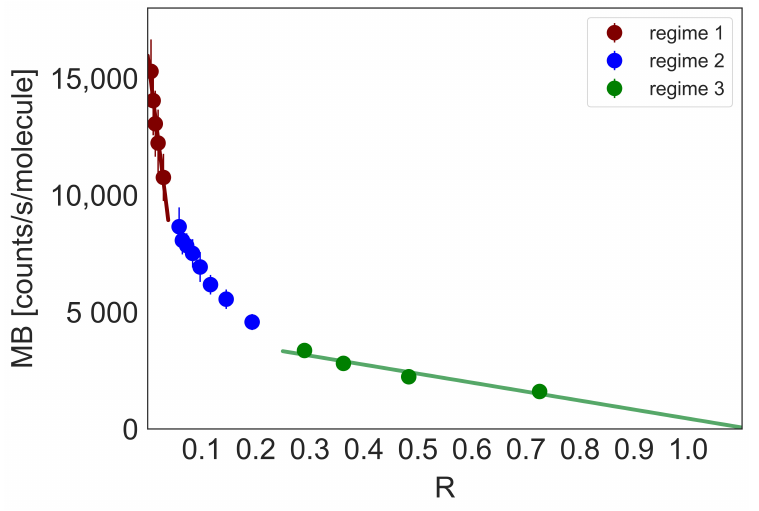
Figure 3. The changes of the average molecular brightness (MB) of the YOYO-1 upon the reaction with the DNA (69 bp) plotted as a function of the ratio of YOYO-1 to DNA in bp concentrations. Depending on R, we can distinguish three different trends of the MB change. Regime 1 corresponds to the bis-intercalated YOYO-1 complex, regime 3 to the mono-intercalated YOYO-1. In regime 2, both intercalation reactions occur. The fraction of each mono and bis-intercalated dye changes with